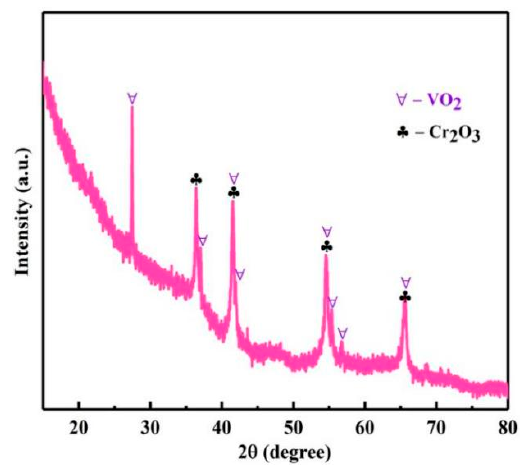
Figure 20. XRD analysis of the product.